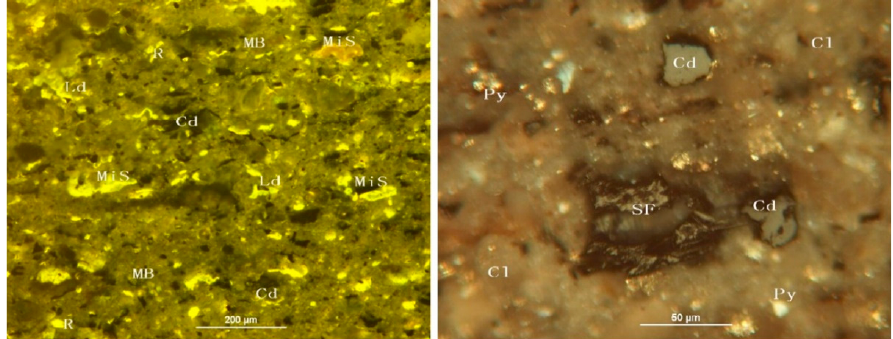
Figure 6. Analysis of the organic microscopic composition of the whole-rock P 2 l 1 sample (2321.4 m) from Well Ji15 (left image: reflected fluorescence; right image: reflected plane-polarized light). Cl is clay; MiS is microsporinite; R is resinite (R); Ld is liptodetrinite; Cd is vitrodetrinite; SF is semifusinite; MB is mineral bitumen; Py is pyrite.